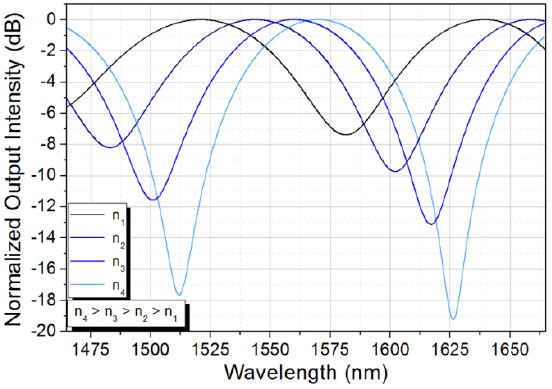
Figure 4. Analytical spectral response of the TCF for different surrounding media.